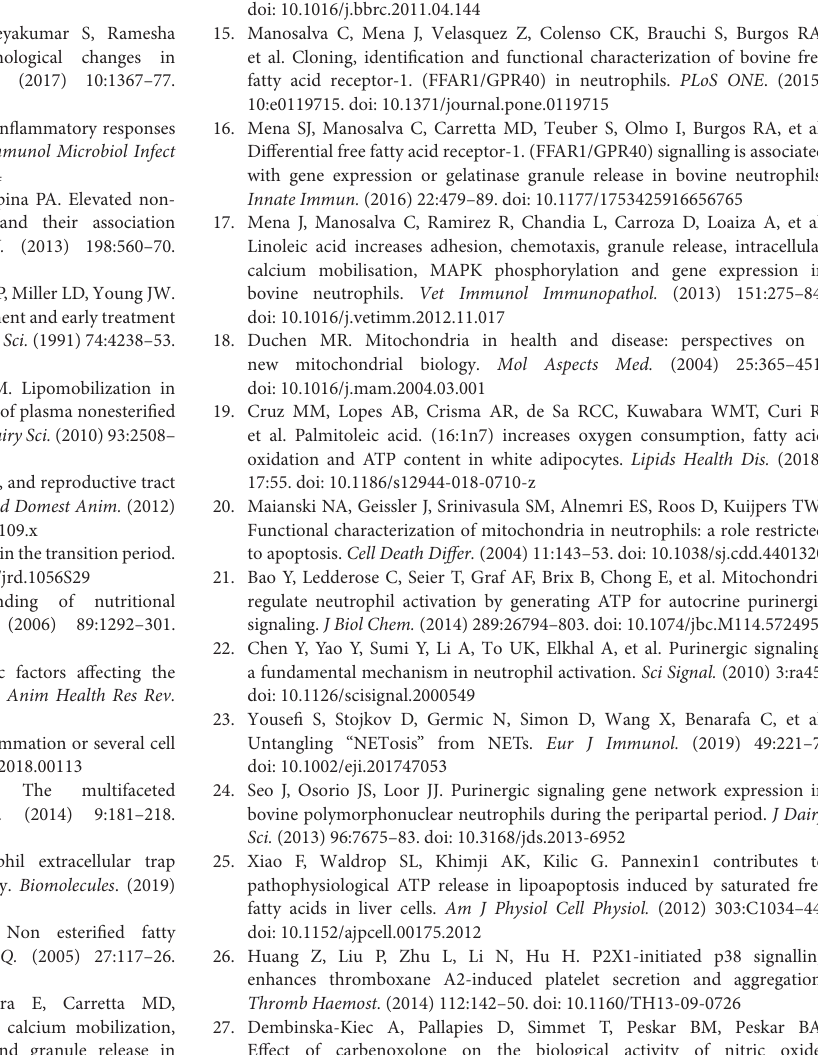
Supplementary Figure 1 | Bar graph (means ± S.E.M.) of cell-free (cf)-DNA of PMN treated with different concentrations of NF449 (potent and selective antagonist of the P2X1 receptor) (A) or 5-BDBD (P2X4 antagonist) (B) of A804598 (P2X7 antagonist) (C) and stimulated with OA. N = 4; ∗∗ p < 0.01, ∗∗∗∗ p < 0.0001 compared with OA treatment